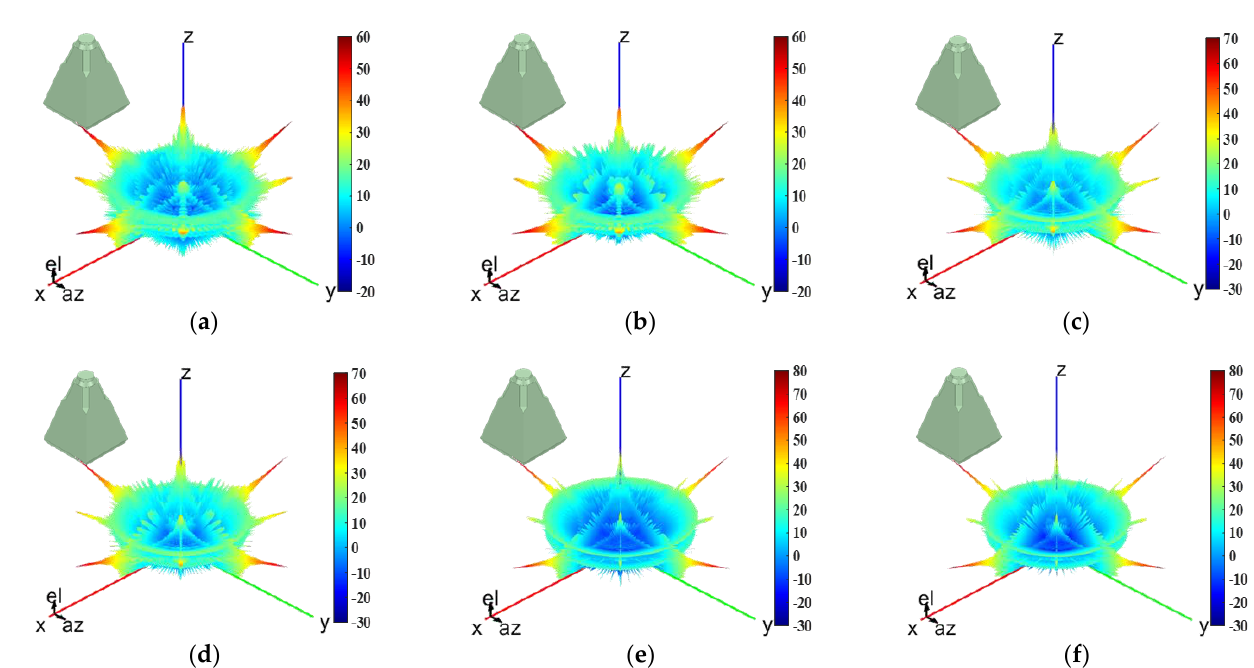
in the X-band, ( f ) VV polarization in the X-band. (Unit: dBsm).